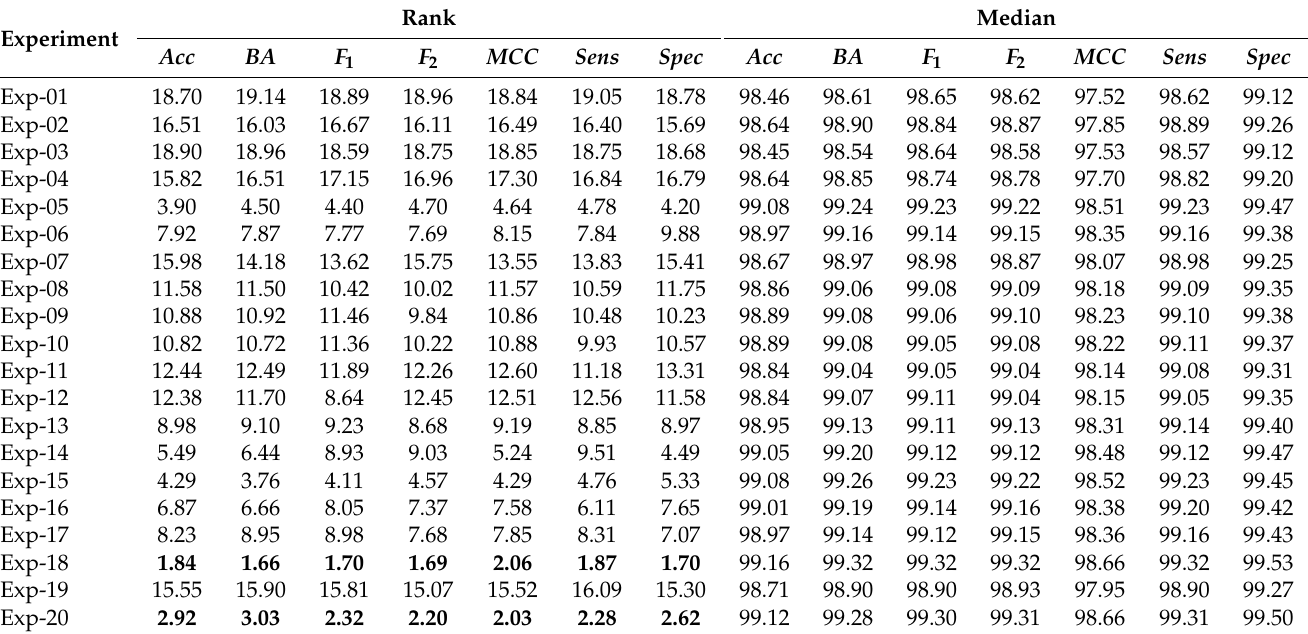
Table 10. Ranks by experiment after 1000 bootstraps cycles. Best results are highlighted in bold. Experiments 18 and 20 correspond to ResNet-50r with AdamW, CE (18) and wCE (20).